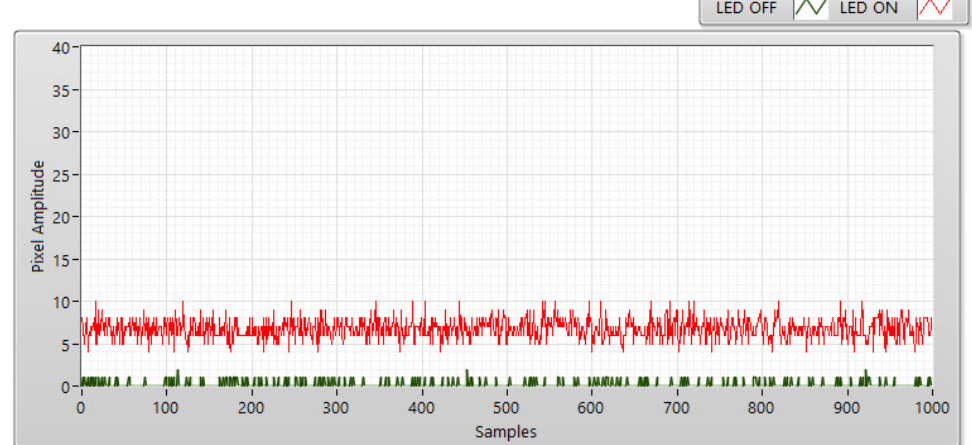
Figure 9. The SNR measurement using a rolling-shutter camera at 20 m and a 50 μs exposure-time setting.